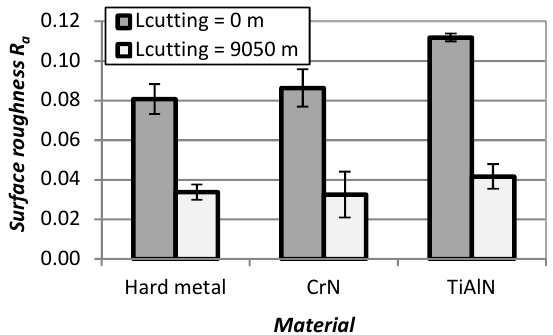
Figure 12. Roughness levels of the rake surface (area of cutting edge) of new cutters and cutters after the 9050 m path (with and without PVD coatings).